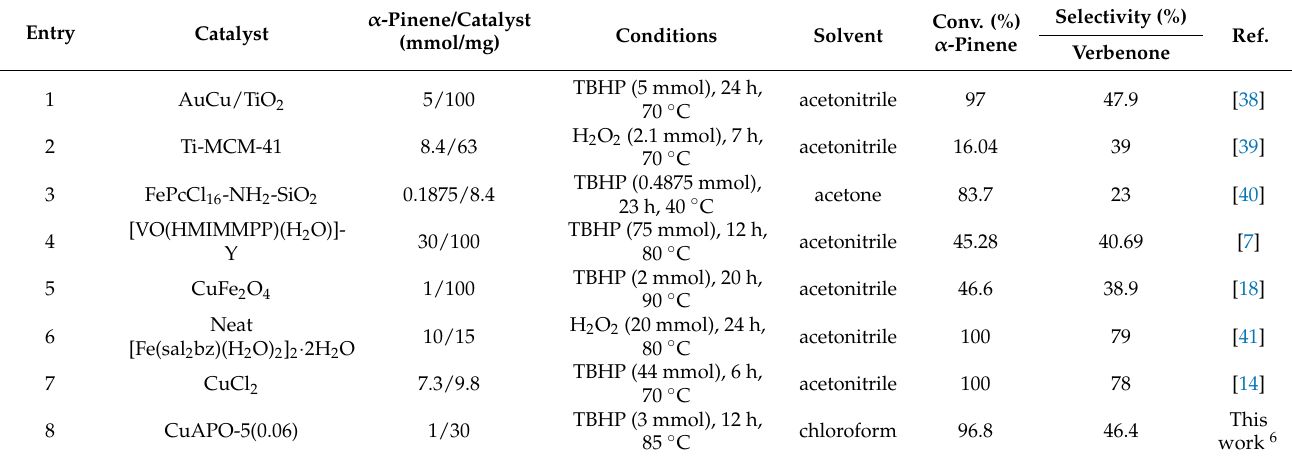
Table 5. Comparison of catalytic properties of different catalysts for the synthesis of α -pinene into